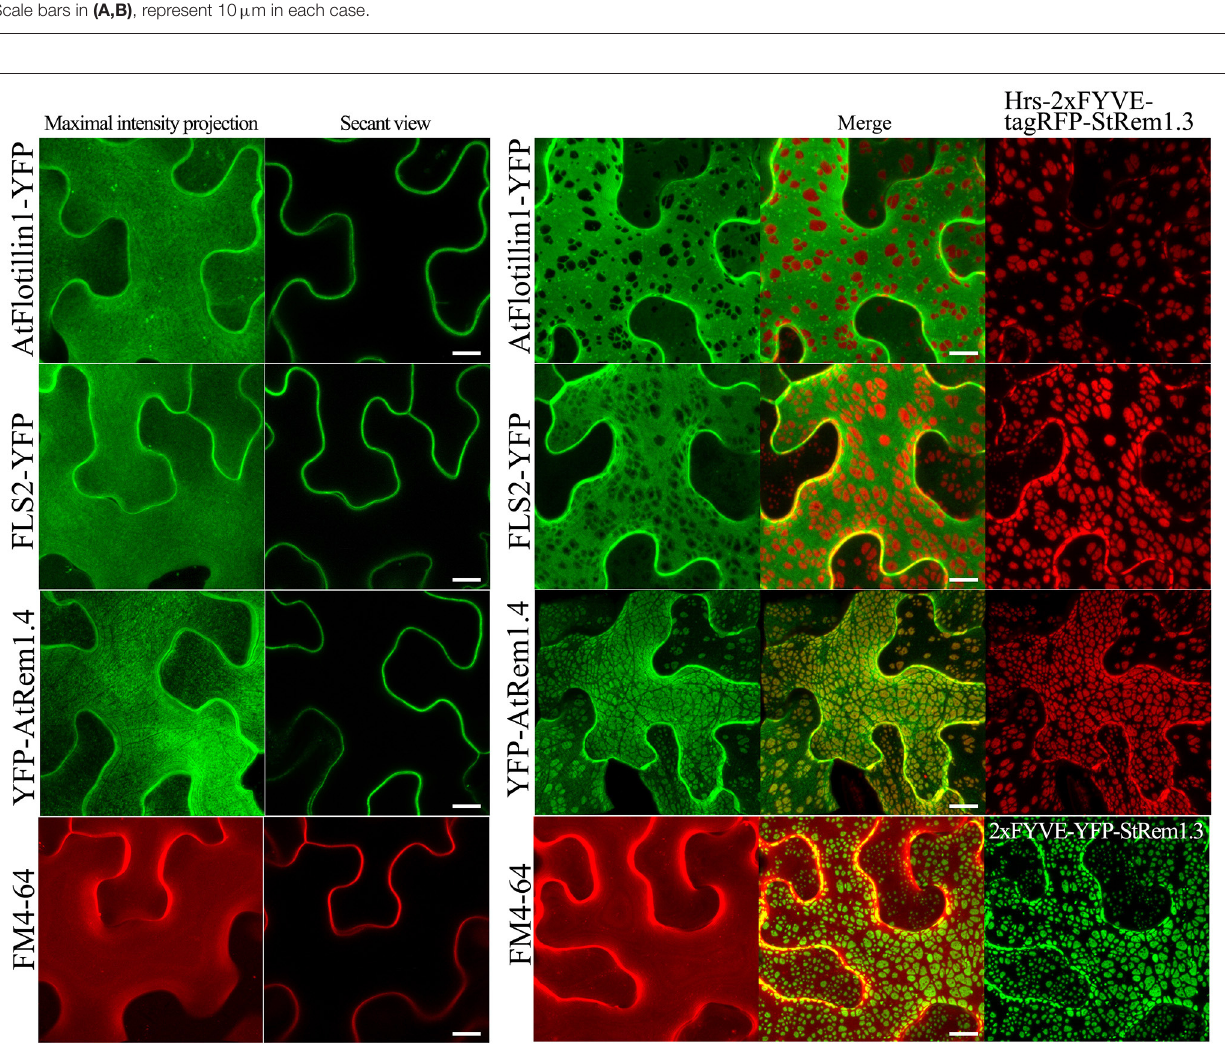
FIGURE 5 | Distribution of fluorescently tagged PM-localized proteins in the presence of membrane patches in N. benthamiana leaf cortical cells. Left panels: the distribution of PM-targeted proteins expressed alone, including YFP-tagged membrane microdomain protein AtFlotillin1, integral membrane protein FLS2, and AtRem1.4 which is the closest Arabidopsis homolog of StRem1.3. Right panels: the distribution of those fluorescently tagged PM proteins co-expressed with Hrs-2xFYVE-tagRFP-StRem1.3. Bottom panels: FM4-64 staining in the presence or absence of expressed Hrs-2xFYVE-YFP-StRem1.3. All scale bars represent 10 µ